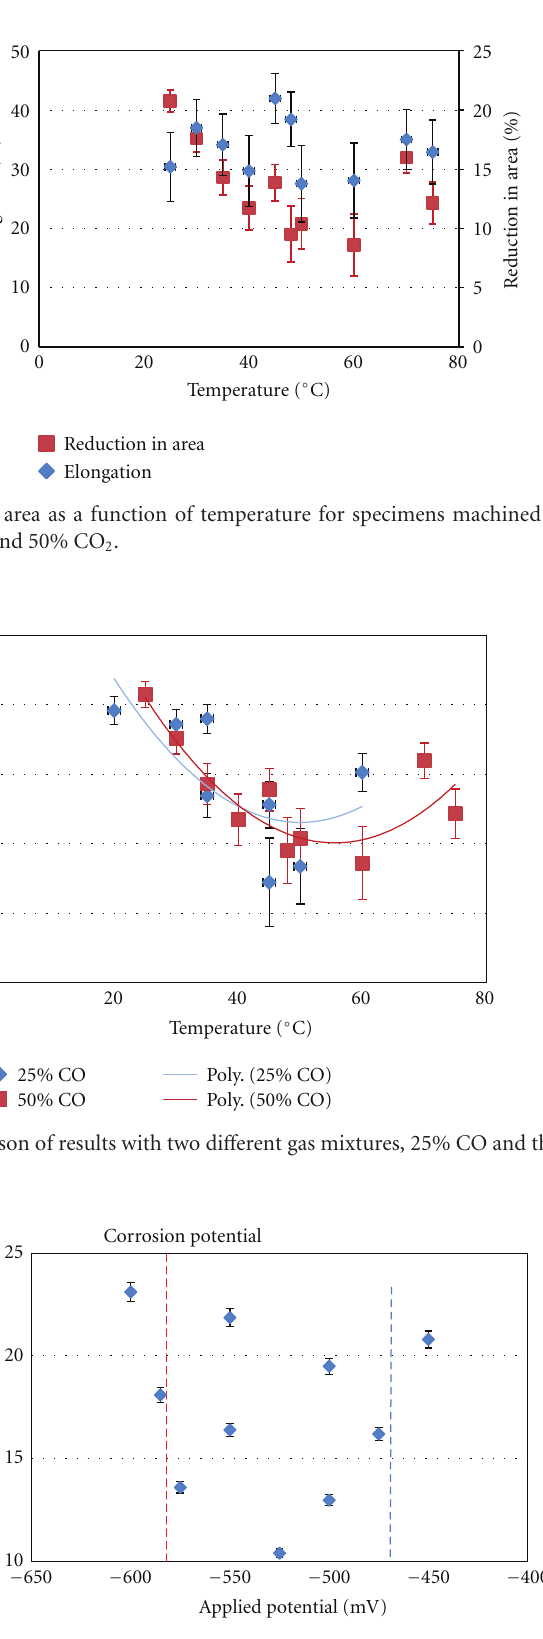
Figure 9: Elongation as a function of the applied electrochemical potential at 800kPa and 45 ◦ C with a gas mixture of 25% CO and 75%